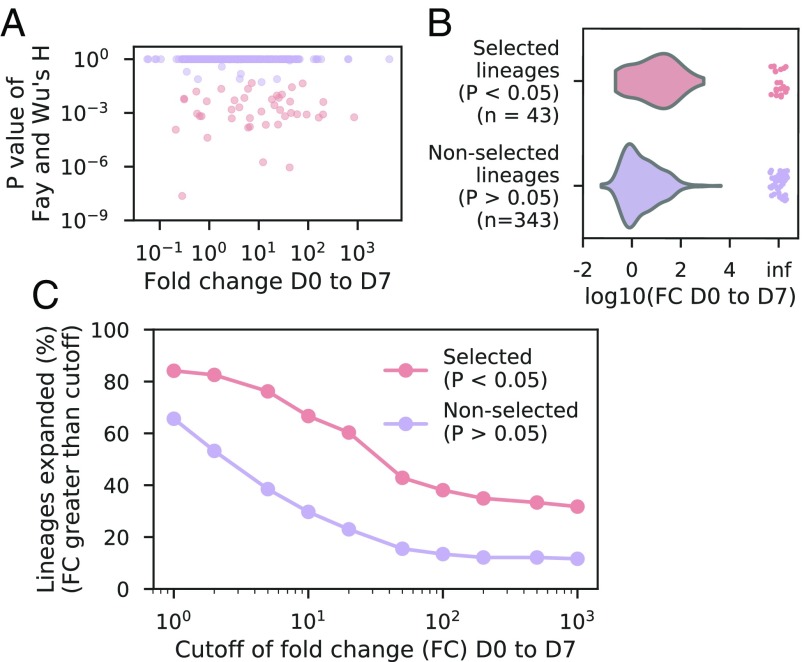
Relationship between genetic signatures of selection and clonal expansion after vaccination. (A) Signatures of selection compared with magnitude of clonal expansion after vaccination. Each dot is a lineage. Color indicates whether a lineage has a significant signature of selection, as indicated by the legend in C. (B) Distribution of magnitudes of clonal expansion after vaccination [fold-change (FC) from D0 to D7] among selected and nonselected lineages. Points at “inf” indicate lineages that were detected at D7 but not at D0 and therefore have undefined FC. (C) Fraction of lineages that exhibited clonal expansion with magnitude exceeding various cutoffs among selected and nonselected lineages.